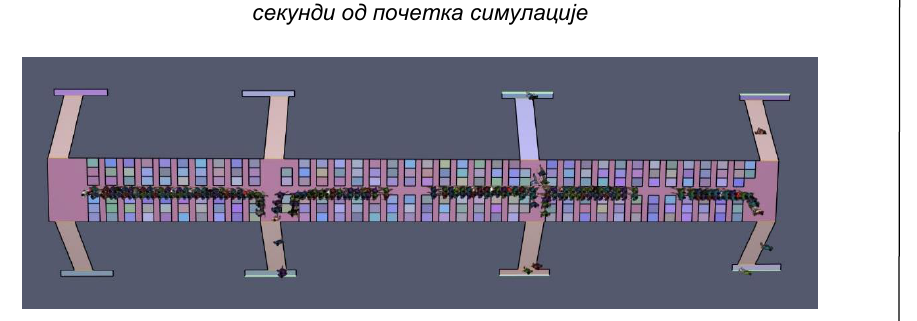
Figure 7 – Simulation moment for the fourth case of the second scenario after 28 seconds after the start of the